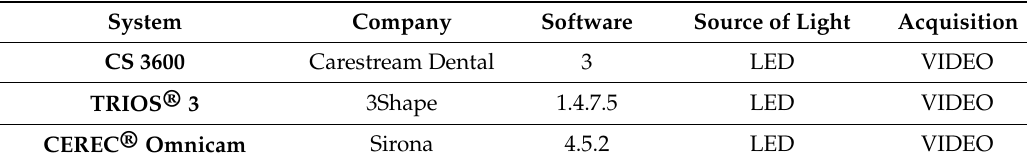
Table 1. Features of the intraoral